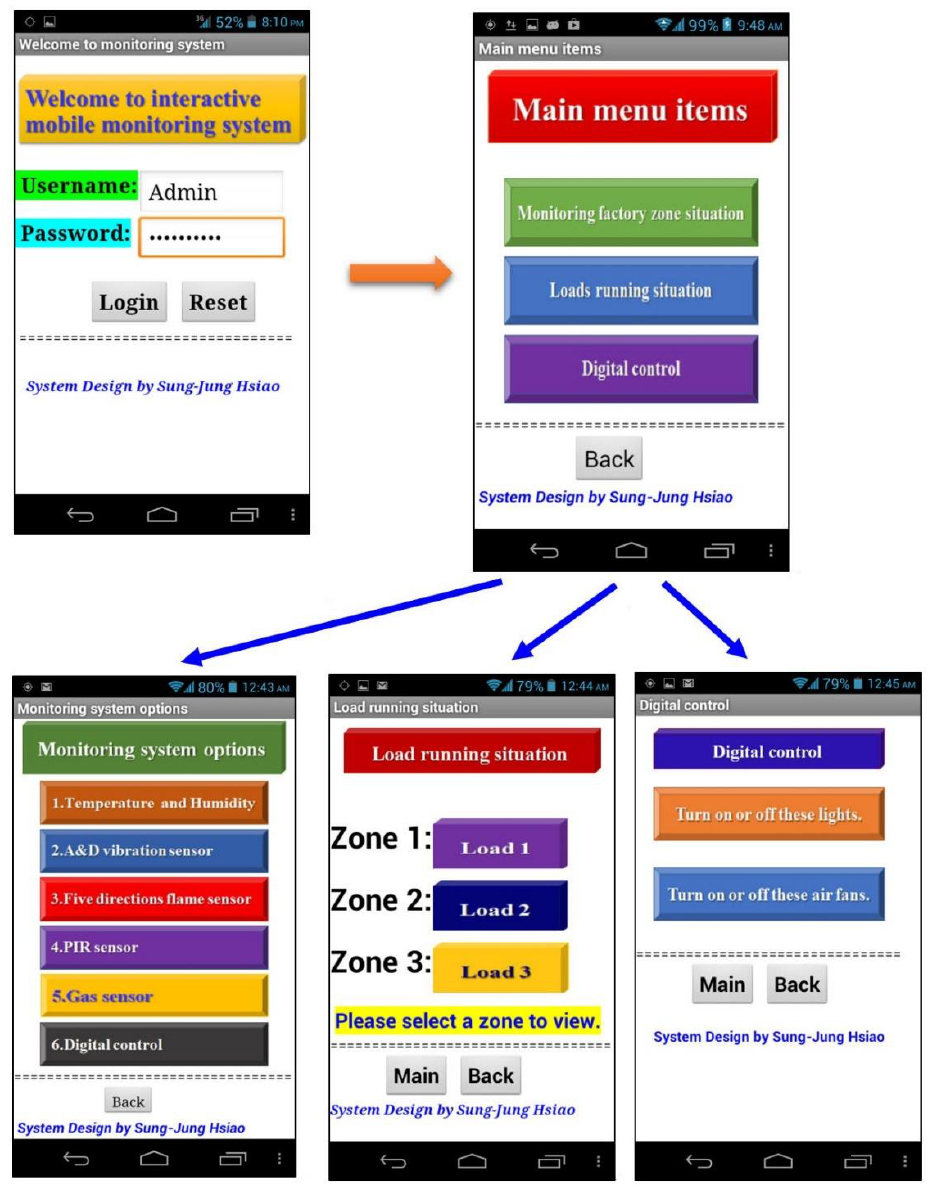
Figure 41. Our interactive monitoring system main menu